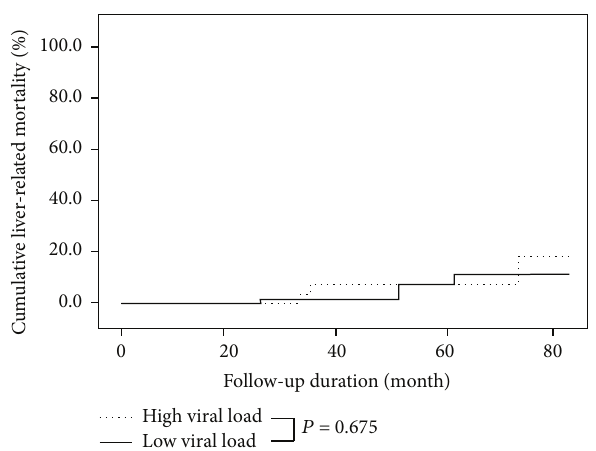
Figure 3: Cumulative liver-related mortality according to the viral load of serum HCV RNA. No significant difference of cumulative liver-related mortality was seen in patients with high or low viral load ( 𝑃 = 0.675